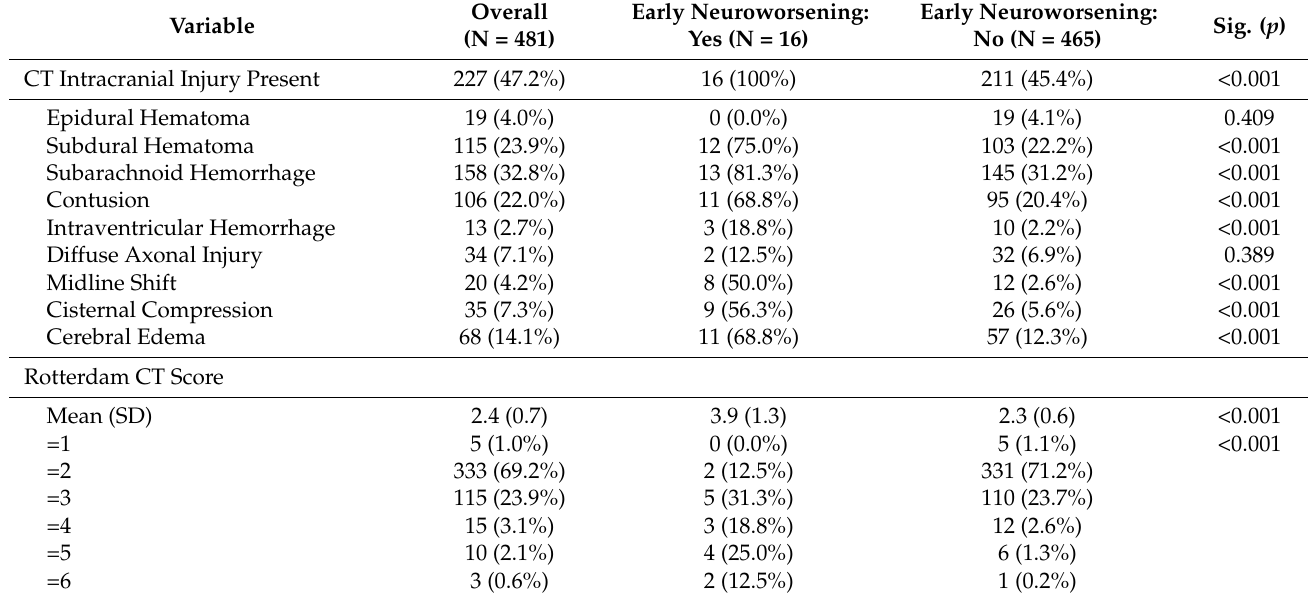
Table 2. Initial head CT characteristics by early neuroworsening. Presence of intracranial injury on initial head CT scan, and major types of intracranial pathology, are shown by early neuroworsening status. The Rotterdam CT score provides the following estimates for 6-month mortality after traumatic brain injury: 1 = 0%, 2 = 7%, 3 = 16%, 4 = 26%, 5 = 53%, 6 = 61%. CT = computed tomography; SD = standard deviation.